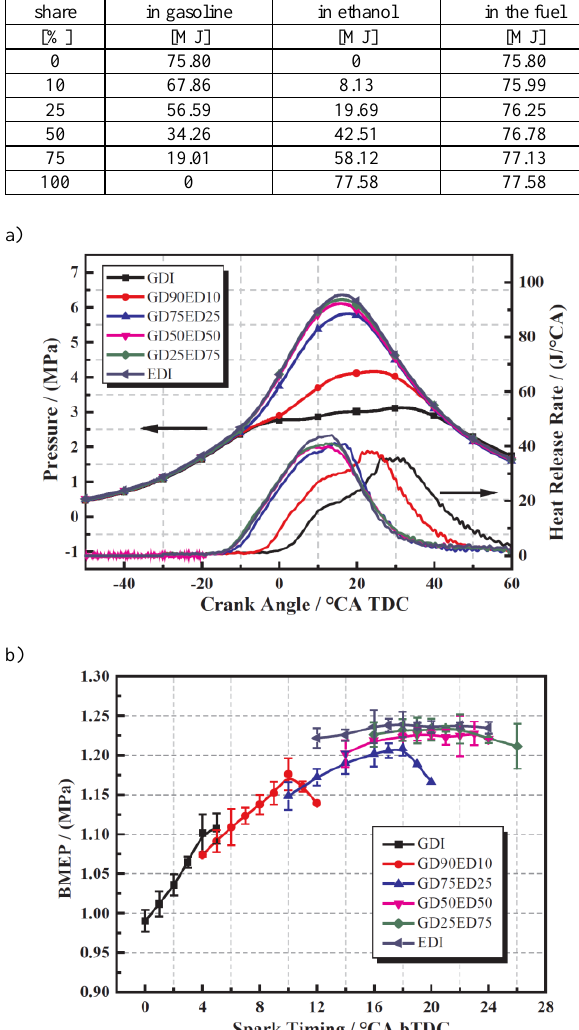
Fig. 7. Indicator tests: a) cylinder pressure curve, b) changes in BMEP as a function of the start of ignition angle (reproduced from [23]) The injection strategy of gasoline direct injection